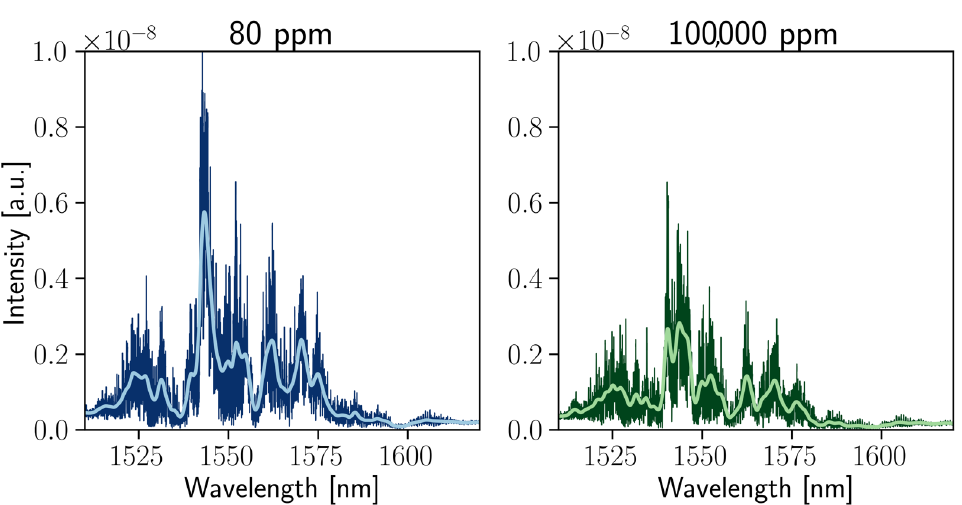
Figure 3. Spectra of the considered structure for two different concentrations of isopropanol solutions in water. Dark lines correspond to the originally measured spectra, whereas light lines correspond to the smoothed data via a 0.6 nm width Gaussian